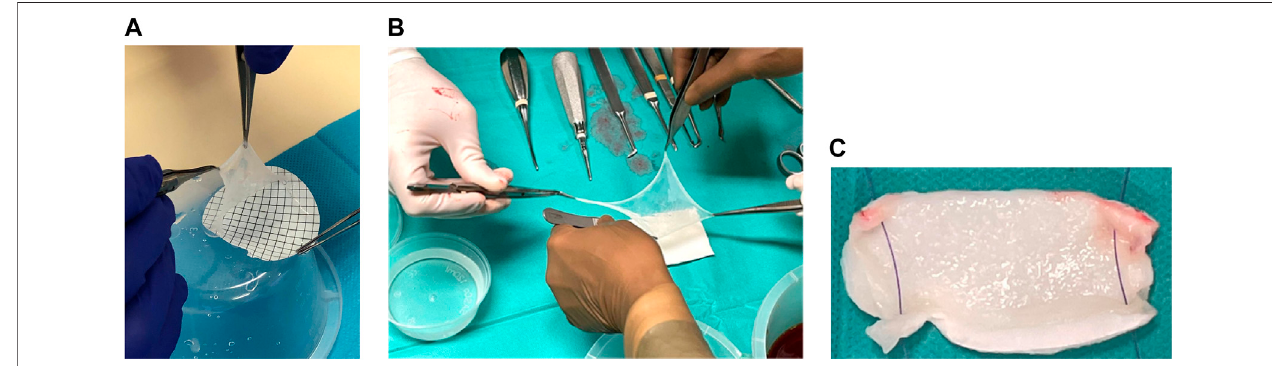
FIGURE 1 | (A) hAM detachment from the nitrocellulose support. (B) hAM application technique option 2: Two operators applied the hAM fl at on the surgical site with “ four hands. ” (C) hAM application technique option 3: hAM was sutured to a collagen sponge (Pangen ® , Urgo medical,